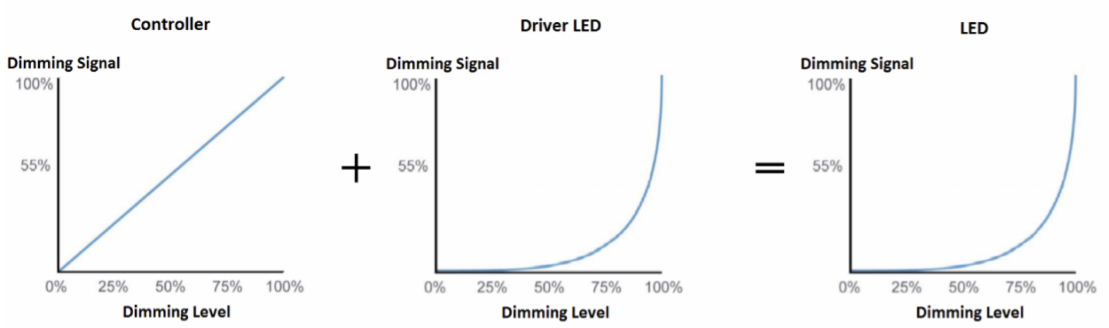
Figure 2. Linear controllers and exponential dimming curve in the LED drivers for exponential LED light source response are necessary; the Dimming Signal (blue) represents the increase of the illuminance